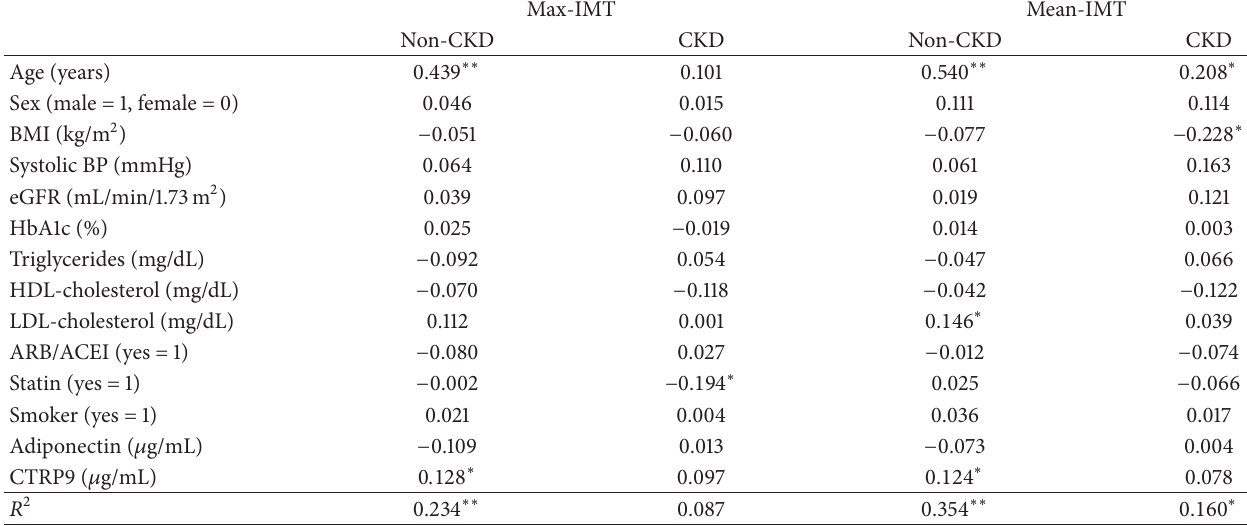
Table 2: Factors independently associated with carotid atherosclerosis in subgroups with and without